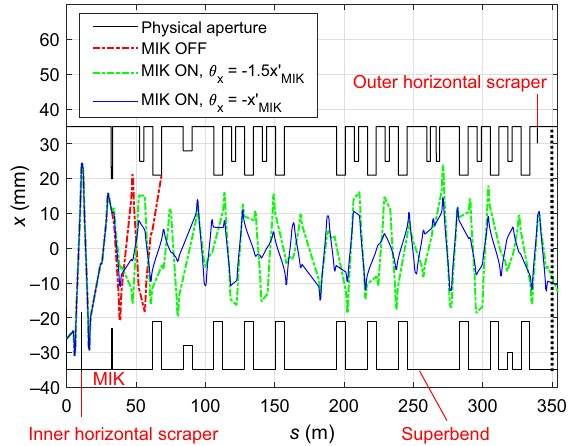
FIG. 10. Horizontal betatron oscillations of the injected beam. If the MIK is switched off, the beam is lost 70 m downstream of the injection point (red dashed curve). If the MIK is switched on, but is too strong ( þ 50% here), then the injected beam oscillates with large amplitude (green dashed curve) and will be lost after a few turns. If the MIK is switched on, and its kick set up to cancel the horizontal deviation of the injected beam at the MIK location, denoted x 0 , then the oscillation amplitude of the injected beam MIK is minimized passing from roughly 25 to 10 mm after the MIK (blue curve). The horizontal scrapers are inserted to their nominal position and the position of the vertical scrapers is represented by the black dotted